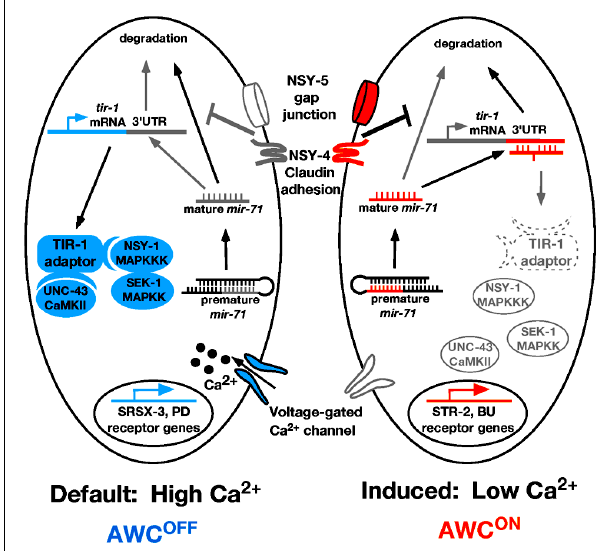
FIGURE 2 | Model of mir-71 function inAWC asymmetry. In the AWC OFF cell, high calcium level activates the calcium-regulated UNC-43/TIR-1/MAPK cascade, leading to srsx-3 expression. In the AWC ON cell, nsy-4 and nsy-5 promote the stability of mature mir-71 through an unknown mechanism.The mature mir-71 miRNA targets the 3 (cid:2) UTR of tir-1 mRNA for degradation, leading to the inhibition of the calcium signaling pathway and the subsequent induction of str-2 expression. Orange color represents factors that promote AWC ON . Blue color represents factors that promote AWC OFF . Gray/white color represents inactive or less active factors. Dotted line represents factors being downregulated. PD, pentanedione; BU,